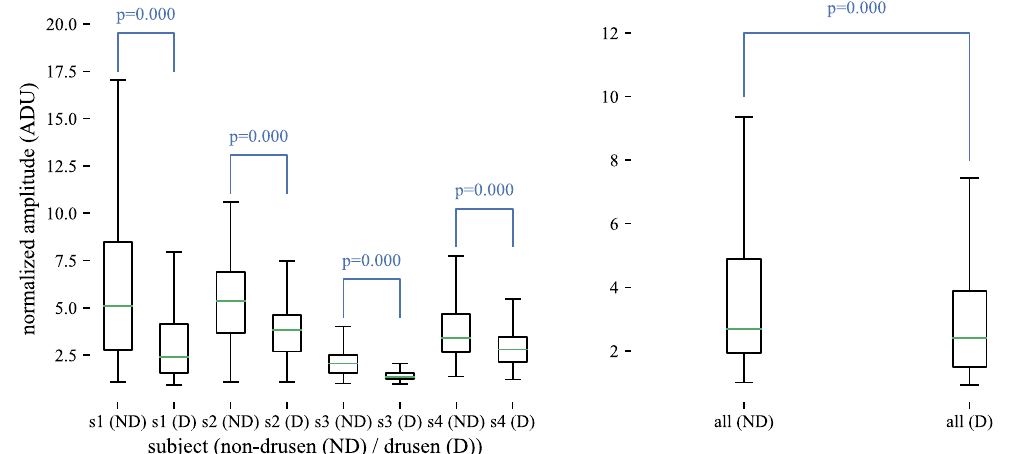
Figure 3. Gross differences between IS/OS amplitude of the two zones. (Left) IS/OS amplitude a I as a function of subject and zone. Within each subject, significant differences were found in a I between drusen and non- drusen zones ( p < 10 − 3 ), with the apparently healthy IS/OS having higher amplitude in all subjects than IS/OS overlying drusen. (Right) When the data from each zone were pooled among subjects, the significant difference persisted ( p < 10 − 3 ) in spite of inter-subject variation in gross IS/OS reflectance. These results illustrate that the IS/OS band over drusen has a lower amplitude than that in healthy retina. Although IQRs overlap in the individual and pooled plots, results are significant due to the large numbers of samples ( 6154 ≤ N ≤ 32927